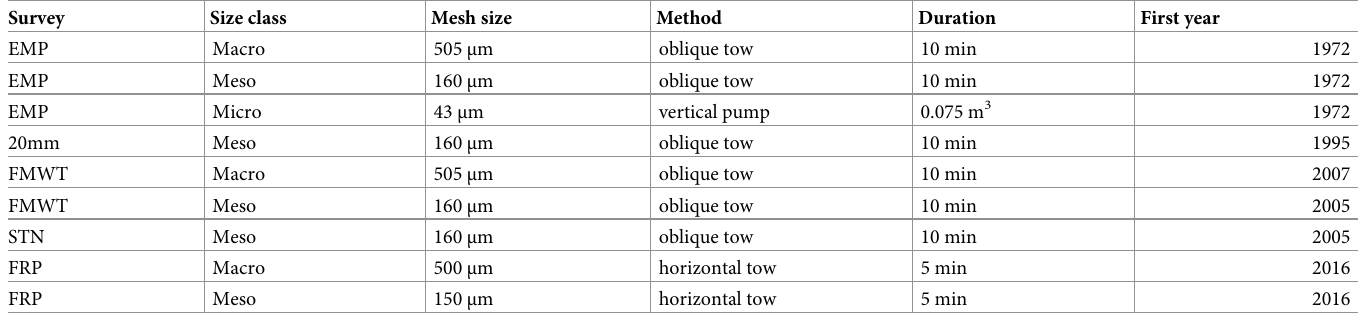
solved oxygen, and concentration of the harmful alga Microcystis sp. for some years (Table 1). Table 2. Current sampling methods for each gear type and